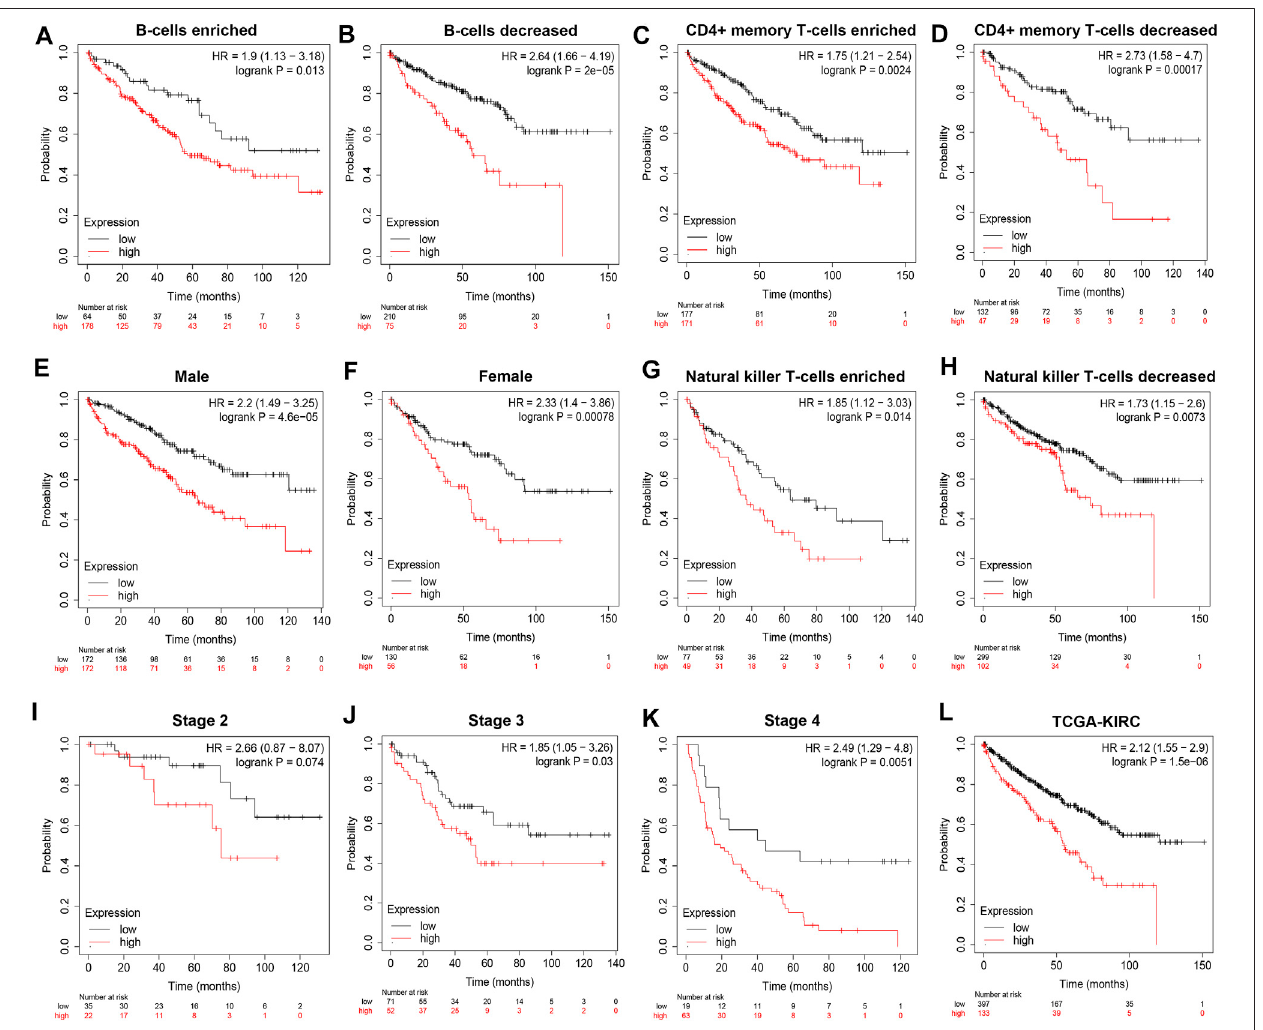
FIGURE 2 | High expression of polymerase epsilon (POLE) is associated with poor survival of clear cell renal cell carcinoma (ccRCC) patients. (A – L) Subgroup survival analysis, including clinicopathological characteristics and abundance of immune cells in 533 patients with ccRCC (The Cancer Genome Atlas [TCGA] cohort), indicated that high POLE expression is signi fi cantly associated with poor